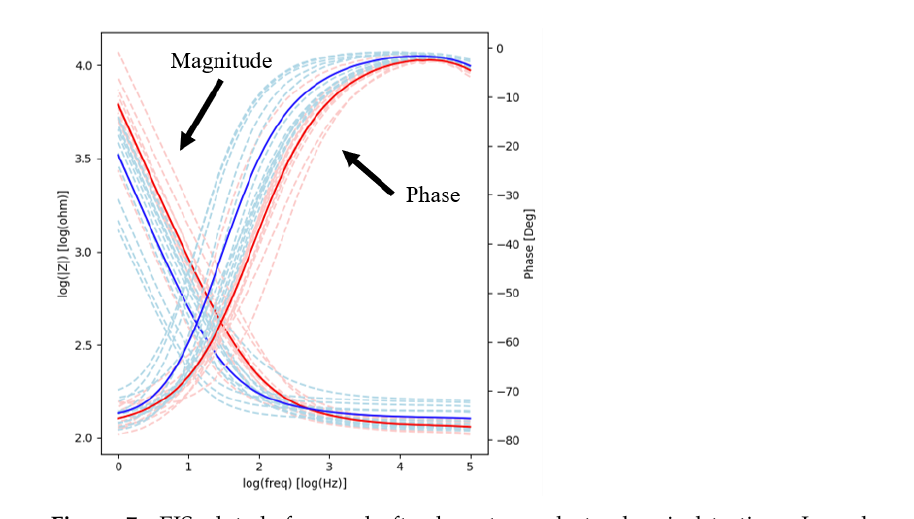
Figure 7. EIS plots before and after long-term electrochemical testing. Impedance magnitude (left Y scale) and impedance phase (right Y scale) are plotted as a function of frequency. The red and blue lines are impedance magnitude and phase measurements made before and after soak and electrical stimulation, respectively. The dashed lines represent all data recorded, and the solid lines are the averages of the respective category. Table 3. EIS measurements before and after long-term electrochemical testing.